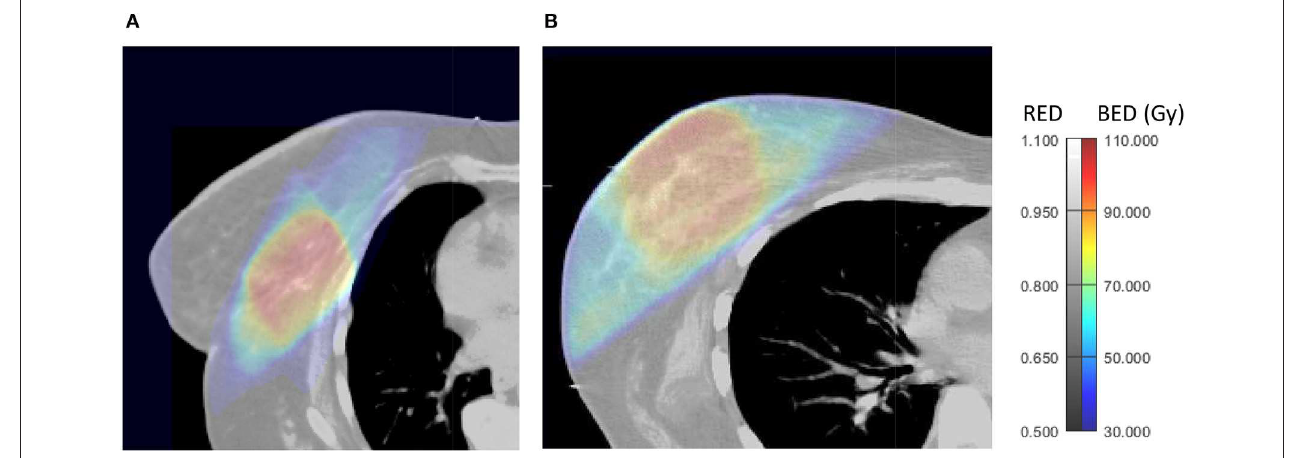
FIGURE 1 | Axial views of 3D-BED and 3D-RED in a patient who did not experience late RIF (A) and one who developed late RIF during follow up (B) .